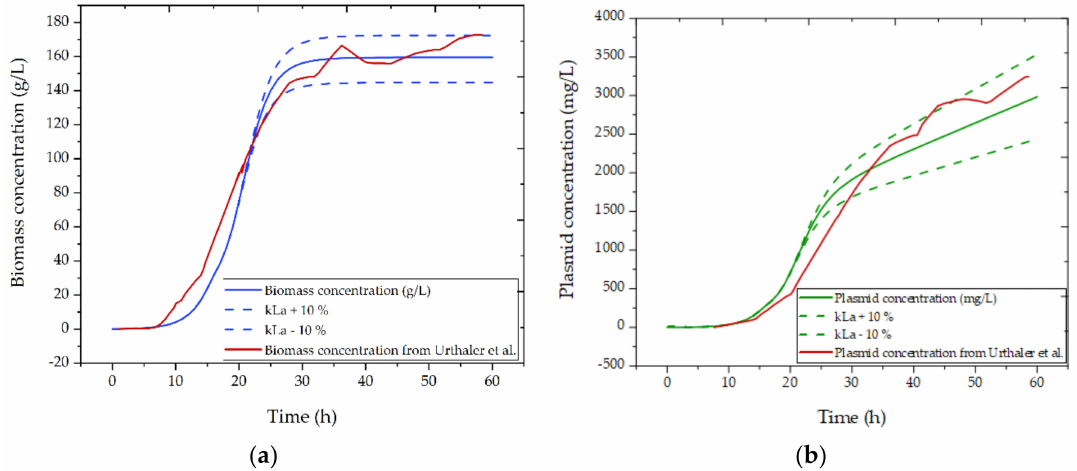
Figure 7. Comparison of literature and simulation data for ( a ) biomass and ( b ) pDNA concentration during fermentation. Multiple simulation runs with varying kLa-values where performed. Dotted lines indicate maximal and minimal biomass and plasmid concentrations.